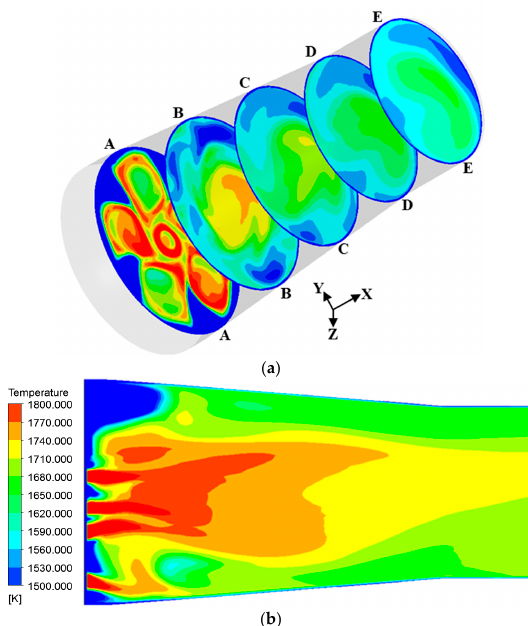
Figure 7. Temperature (K) distribution of combustion gas. ( a ) Various cross-section in the YZ plane along the X direction. ( b ) Combustor cross-section in the middle of the XY plane.